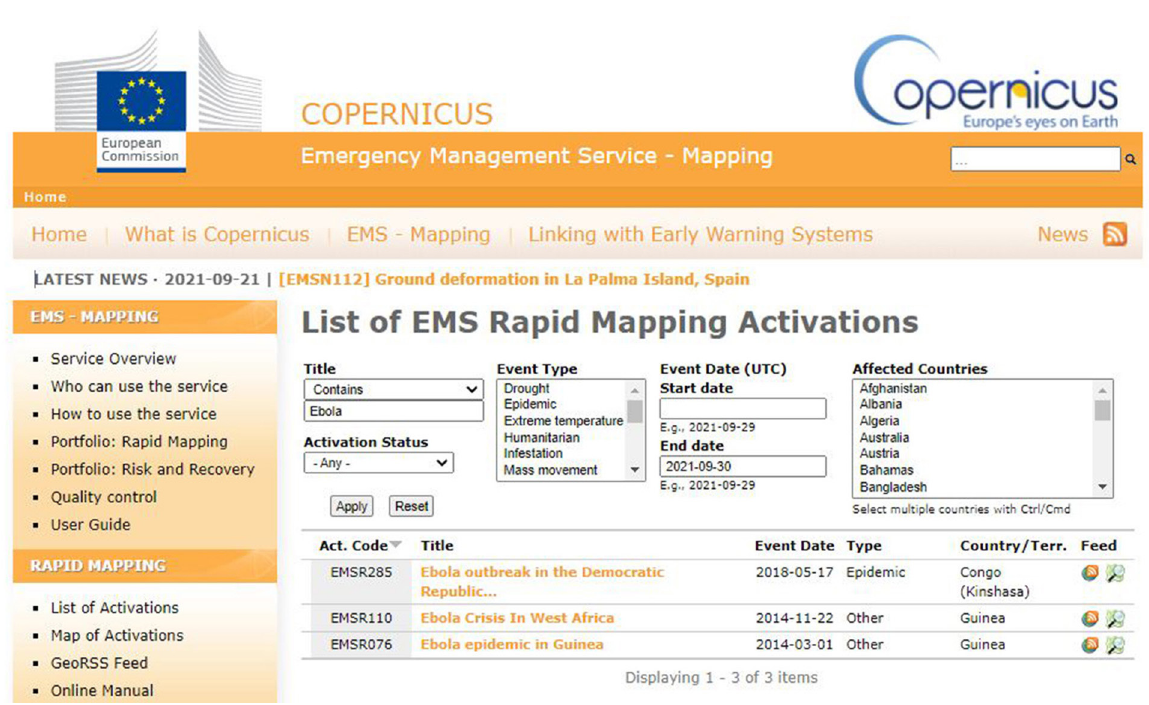
Fig. 5. Result of a search for the term Ebola in the list of activations of the Emergency Management Service of the Copernicus system